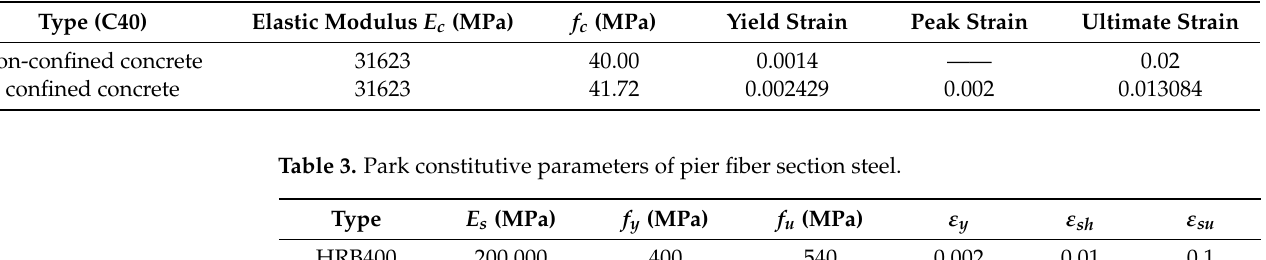
Table 2. Mander constitutive parameters of pier fiber section concrete.